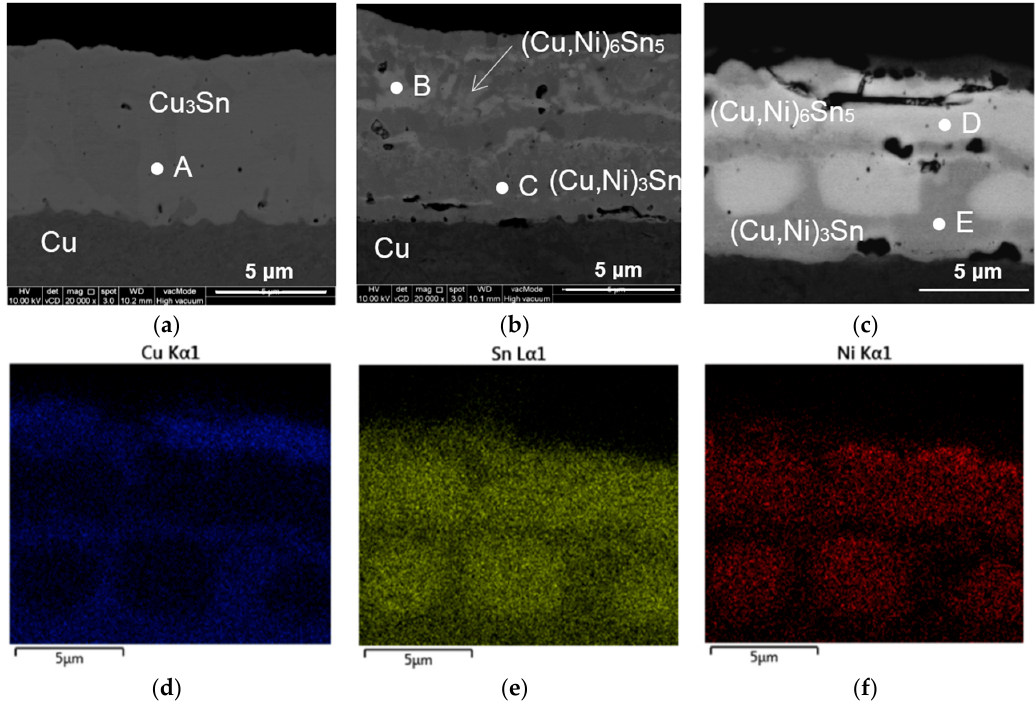
Figure 4. FESEM micrographs showing cross sectional images of ( a ) Cu/Sn; ( b ) Cu/Ni-35/Sn and ( c ) Cu/Ni-70/Sn and EDX elemental maps of ( d ) Cu; ( e ) Sn; and ( f ) Ni, of Cu/Ni-70/Sn after reflow at 300 °C for 60 min. Table 2. Number of voids vs. diameter of voids in Cu/Sn and Cu/Ni/Sn aged at room temperature for 24 days.